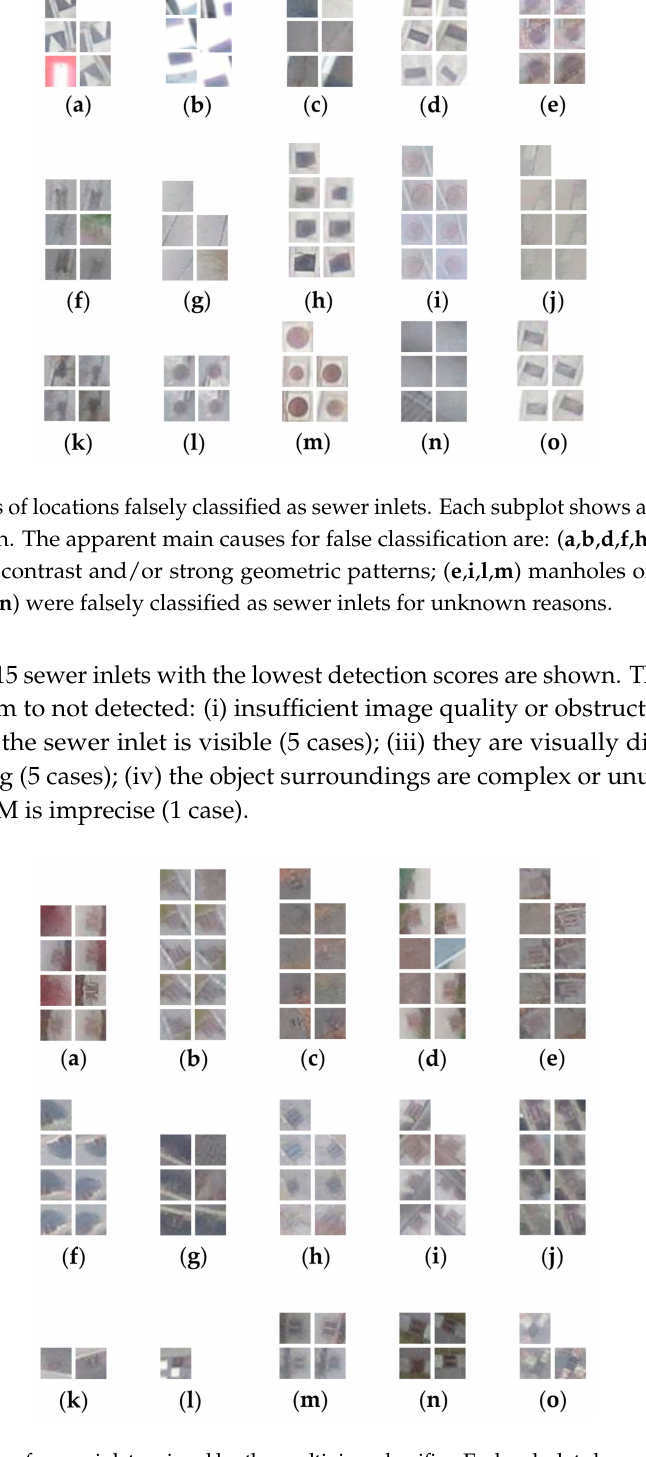
Figure 10. Examples of sewer inlets missed by the multiview classifier. Each subplot shows all views available for a given sewer inlet. The apparent main causes for nondetection are: ( k – o ) too few images in which the sewer inlet is visible; ( a , c , d , e , g ,) insufficient image quality or obstruction by vegetation; ( f , o ) the object surroundings are complex or unusual; ( b , e , h , i , j ) they are visually different from typical inlets (compare to example training data in Figure 6); ( f ) the image poses are imprecisely determined or imprecise